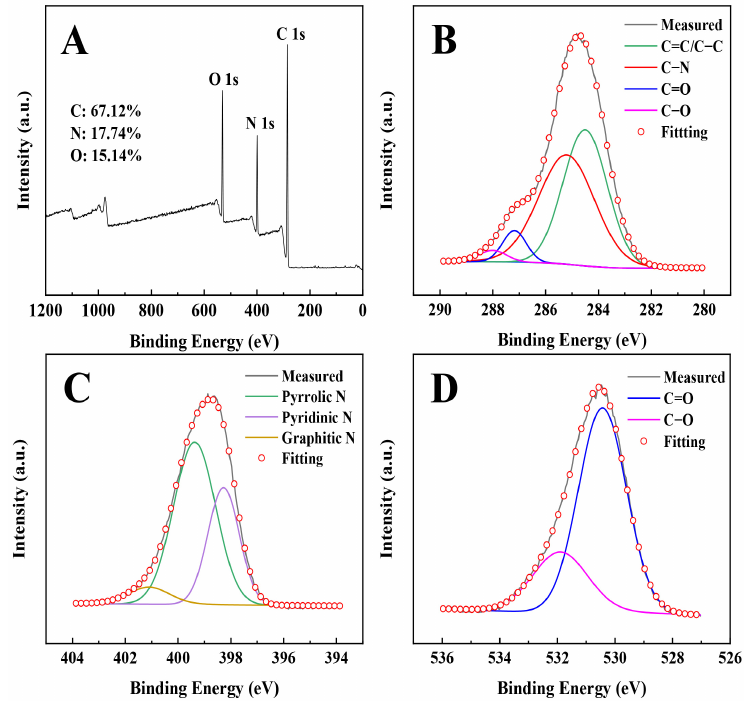
Figure 4. ( A ) XPS full scan spectrum of the PEI@CNDs, and high solution XPS spectra of ( B ) C1s, ( C ) N1s, and ( D ) O1s. ( C ) N1s, and ( D )